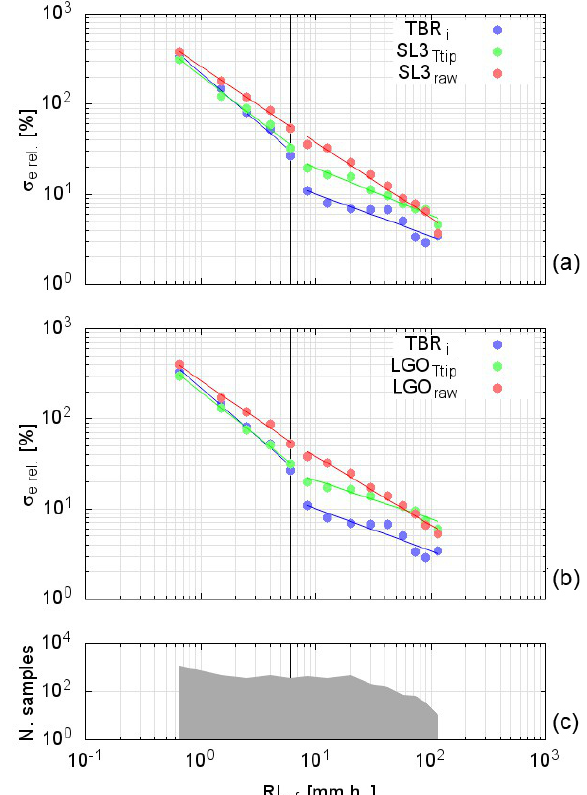
Figure 8. Standard deviation of the relative error for the ideal and investigated TBRGs when adopting the inter-tip time algorithm (Ttip) and the tip-counting method (raw) with respect to the ideal gauge for both the SL3 (a) ad LGO (b) instruments. In panel (c) , the sample size for each RI class is